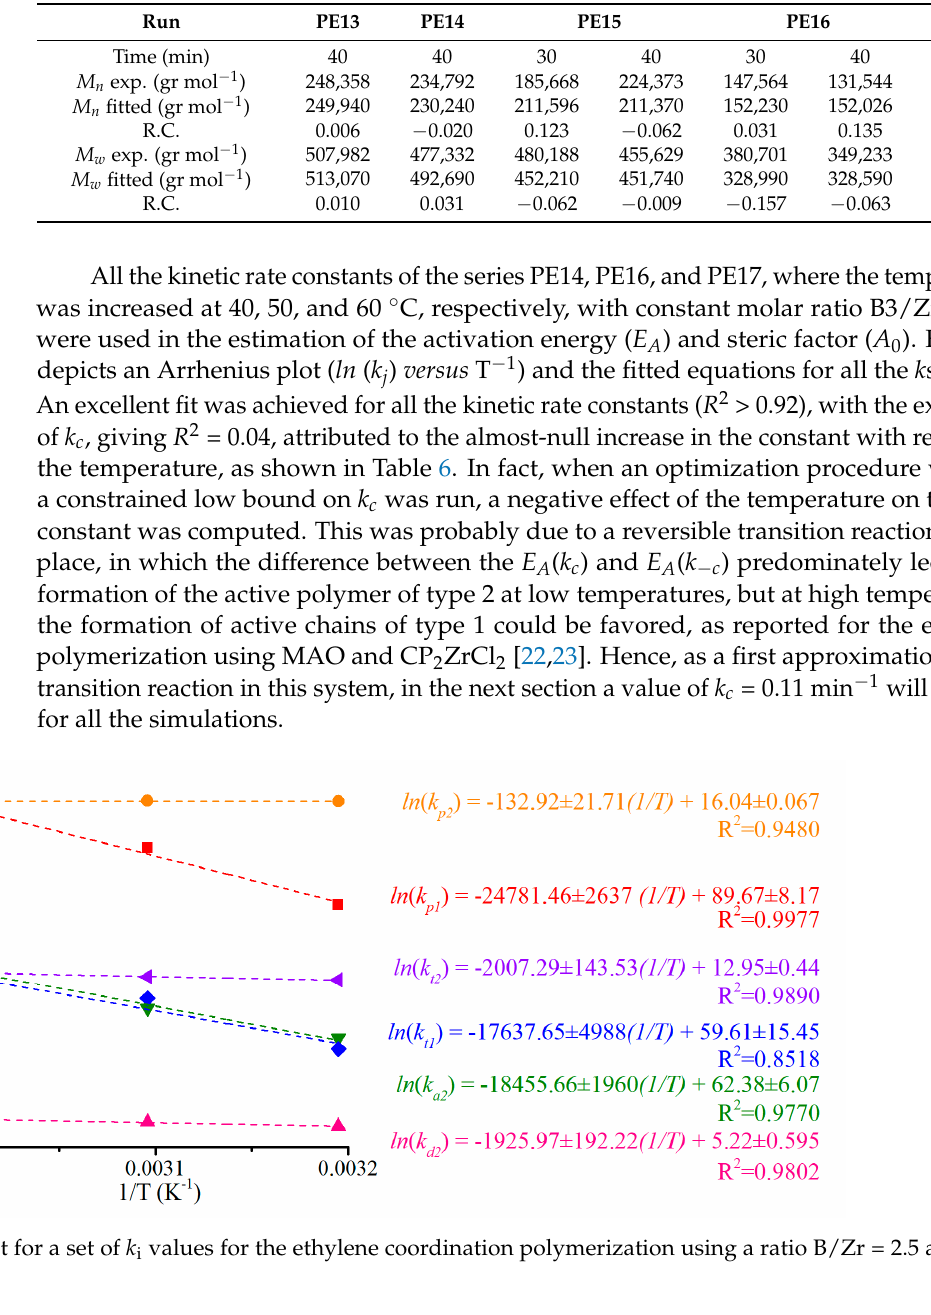
Table 7. Fitted (Model 1) and experimental molecular weights (gr mol − 1 ) of polyethylene, and the relative change (R.C.). P = 150 bar.